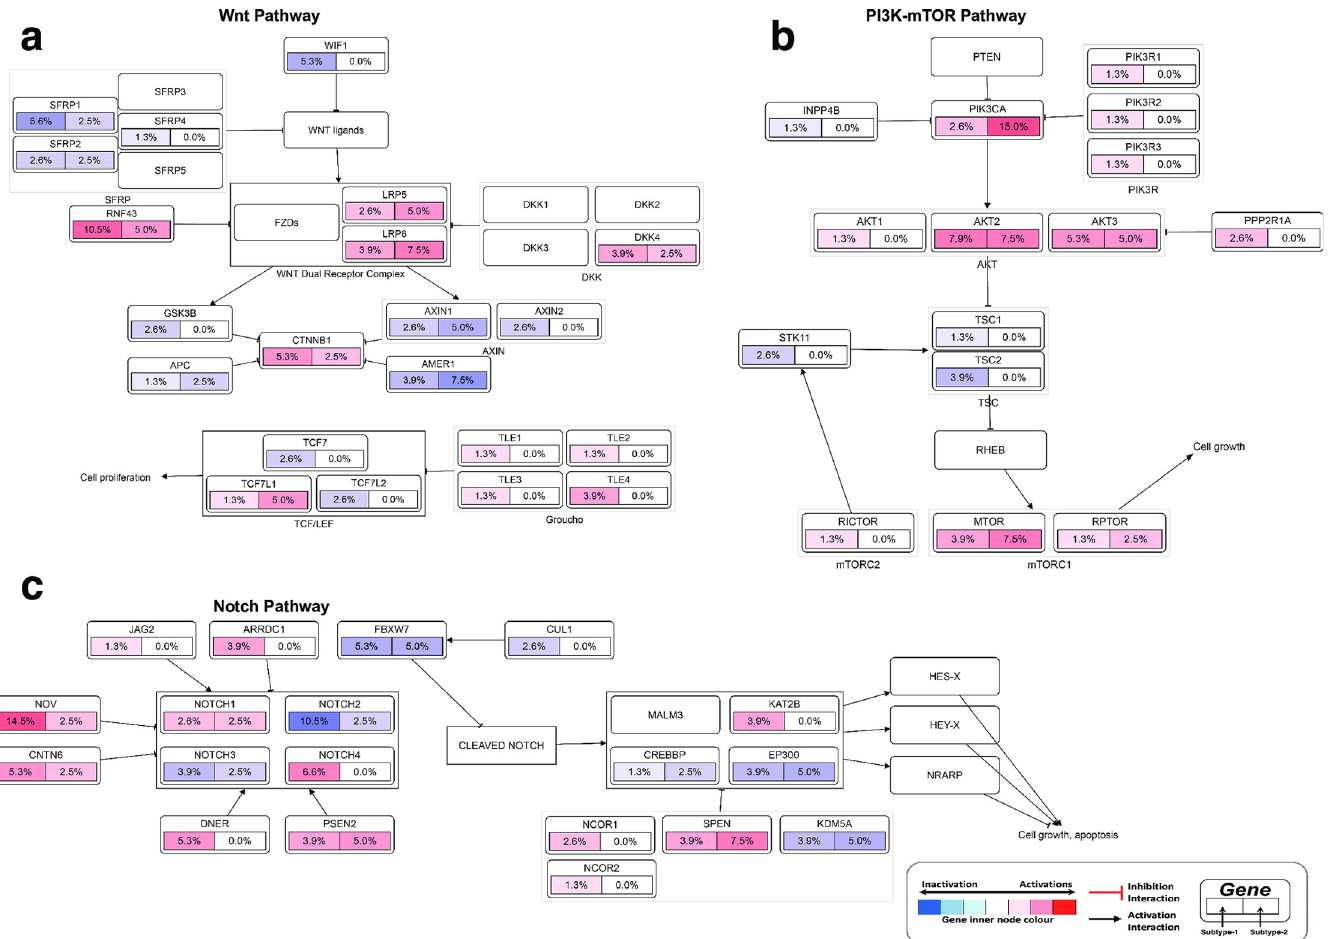
Fig 5. Alterations in (a) Wnt pathway, (b) PI3K-mTOR pathway and (c) Notch pathway. The node represents the percentage of each gene mutation and copy number alterations of (left half) subtype-1 and (right half) of subtype-2 pancreatic tumours. The nodes are coloured according to the types of genes: Blue nodes for tumour suppressor genes and red for oncogenes. The interaction types are as given in the figure